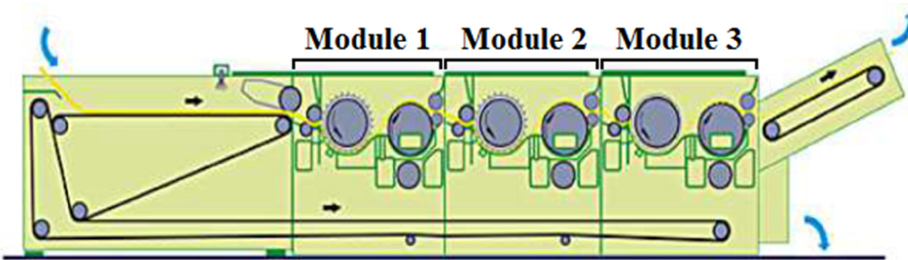
Figure 2. Laroche Cadette 1000 “all fibre” extraction device used in this study (from Laroche company website, https://laroche.fr, accessed on 21 June 2021).